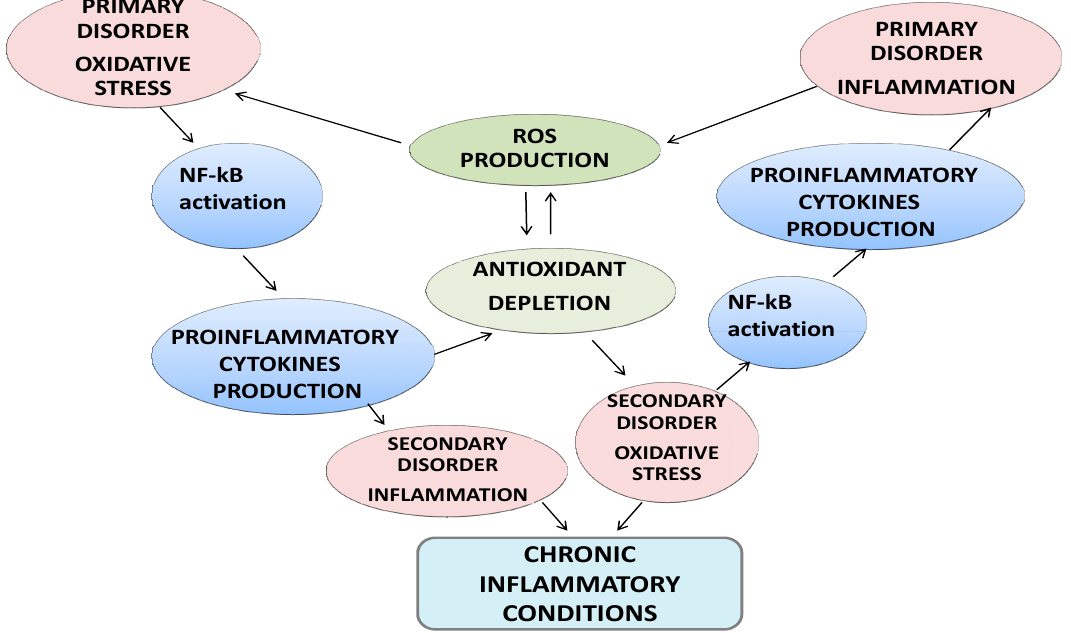
Figure 1. Crosstalk between oxidative stress and inflammation and clinical consequences.